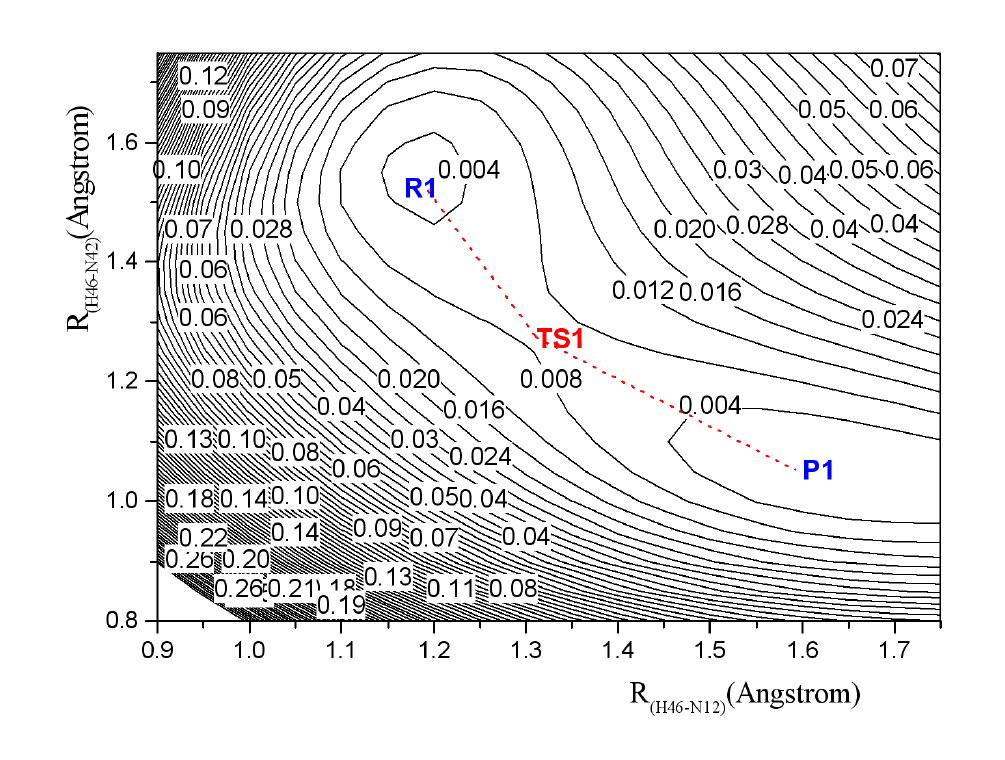
Fig. 4 The potential energy surface and the minimum energy pathway (the unit of contour is